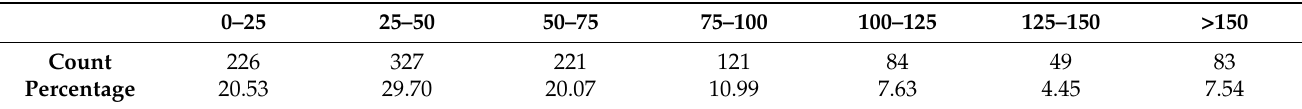
Table 2. Distance error distribution for our algorithm using the baseline model (in